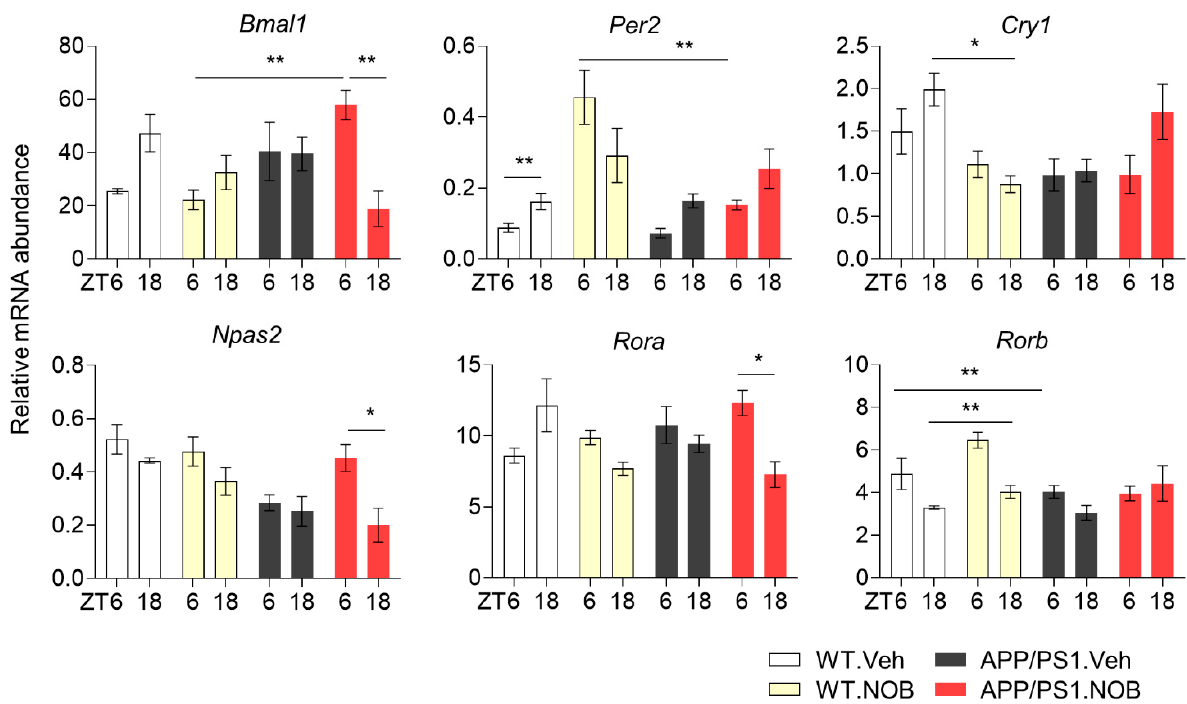
Figure 3. Effects of NOB on expression of core clock genes in WT and APP/PS1 mice. mRNA expression of core clock genes in cortex tissues was measured via real-time qPCR (n ≥ 3/each group). Mice were sacrificed at ZT6 and ZT18 under the LD condition. Data represented by mean ± SEM in bar graph. * p < 0.05, ** p < 0.01 two-way ANOVA with Tukey’s multiple comparisons.